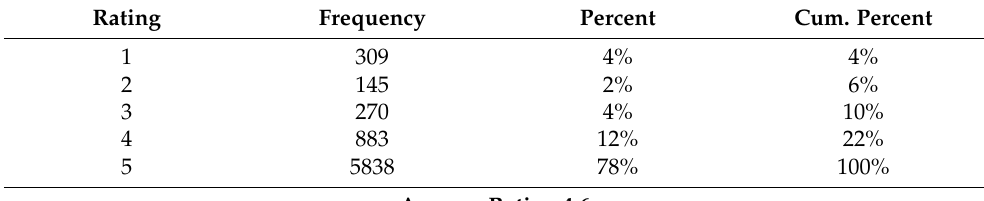
Table 2. Overview of the overall satisfaction rating.